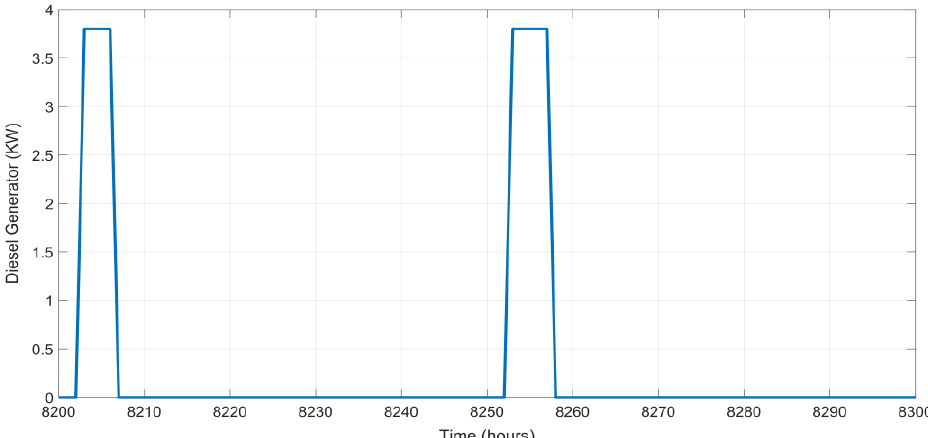
Figure 21. Power generated by DG during winter season.